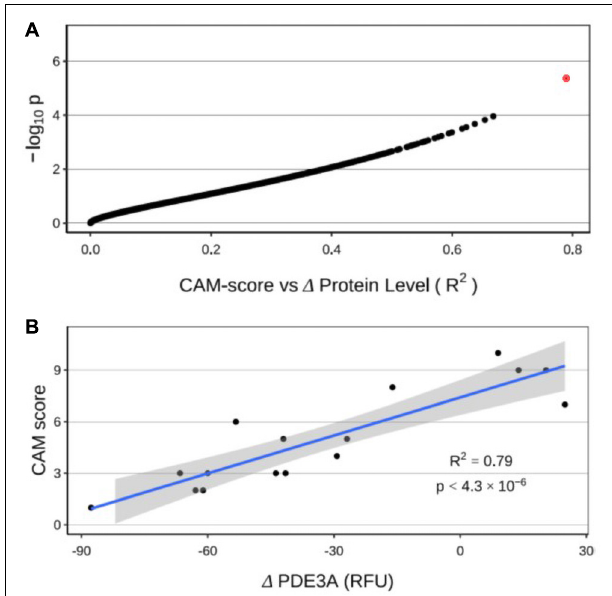
FIGURE 5 | (A) Regression of CAM score against changes in protein levels from preoperative to postoperative states. The red dot represents cGMP-inhibited 3 (cid:48) ,5 (cid:48) -cyclic phosphodiesterase A (PDE3A). (B) Significant correlation of individual changes in PDE3A concentration with CAM score.